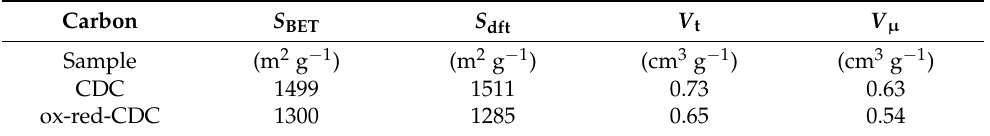
Figure 1. Pore size distribution of CDC and ox-red-CDC calculated from N 2 isotherms (inset). Table 1. Specific surface area ( S BET and S dft ), total pore volume ( V t ), and volume of micropores ( V µ ) calculated from N 2 adsorption.